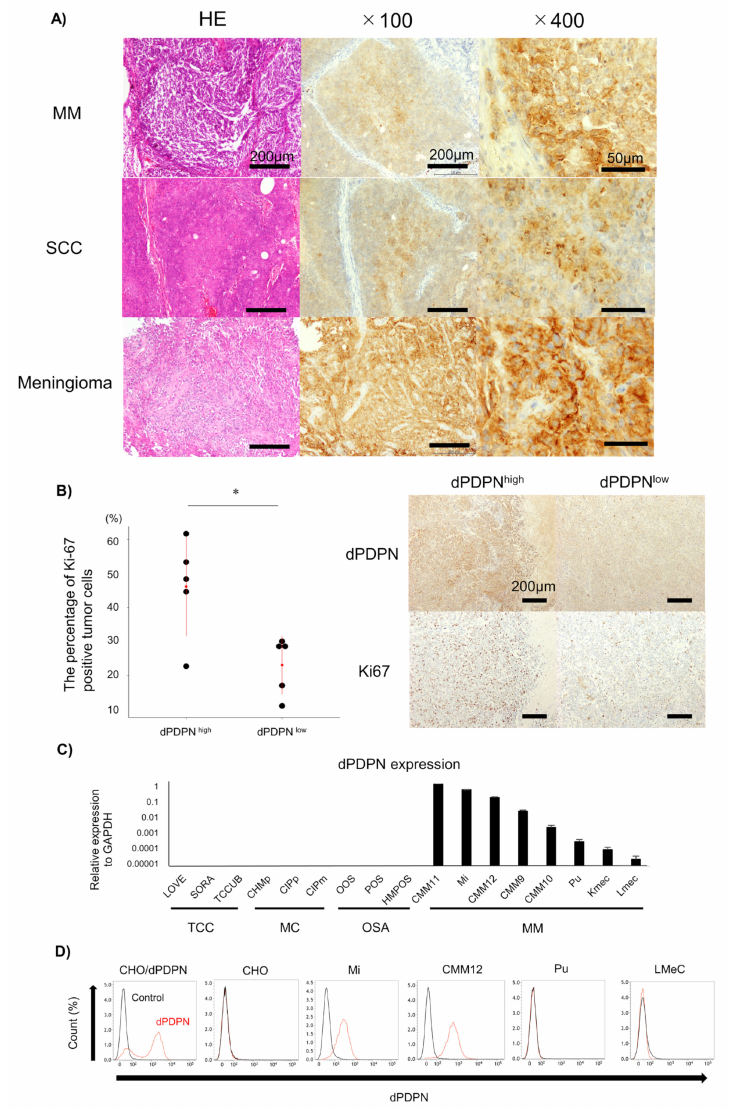
Figure 1. Evaluation of dPDPN expression in canine tumor tissues and canine cell lines. ( A ) Representative images of hematoxylin and eosin (HE) staining and immunohistochemistry of dPDPN in canine nine malignant melanoma (MM), squamous cell carcinoma (SCC) and meningioma are shown. Scale bar, left: 100 µ m, center: 100 µ m, right: 50 µ m. ( B ) (Left panel) The percentage of Ki67-positive tumor cells in canine MM tissues was compared between the PDPN high-expression group and the PDPN low-expression group. Red point indicates the mean score and red bar indicates SD. Right panel: representative images of dPDPN and Ki67 expression in each group are shown. Scale bar: 200 µ m. ( C ) dPDPN mRNA expression in various types of canine cell lines was evaluated by qPCR. Expression values were calculated relative to GAPDH expression. This experiment was performed in triplicate. ( D ) dPDPN protein expression in canine MM cell lines was evaluated by flow cytometry. Chinese hamster ovary (CHO) / dPDPN and CHO were used as positive and negative controls, respectively. * p < 0.05, hematoxylin and eosin (HE), malignant melanoma (MM), squamous cell carcinoma (SCC), dog podoplanin (dPDPN), transitional cell carcinoma (TCC), mammary carcinoma (MC), osteosarcoma (OSA), Chinese hamster ovary